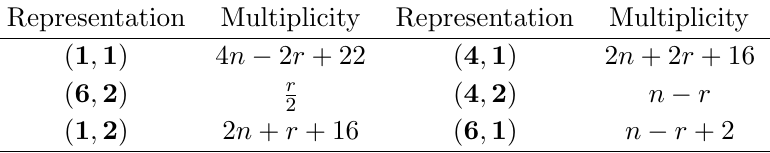
Table 1 . The multiplicity of matter (cid:12)elds (in full hypermultiplets) in the SU(4) (cid:2) SU(2) theory on base F n